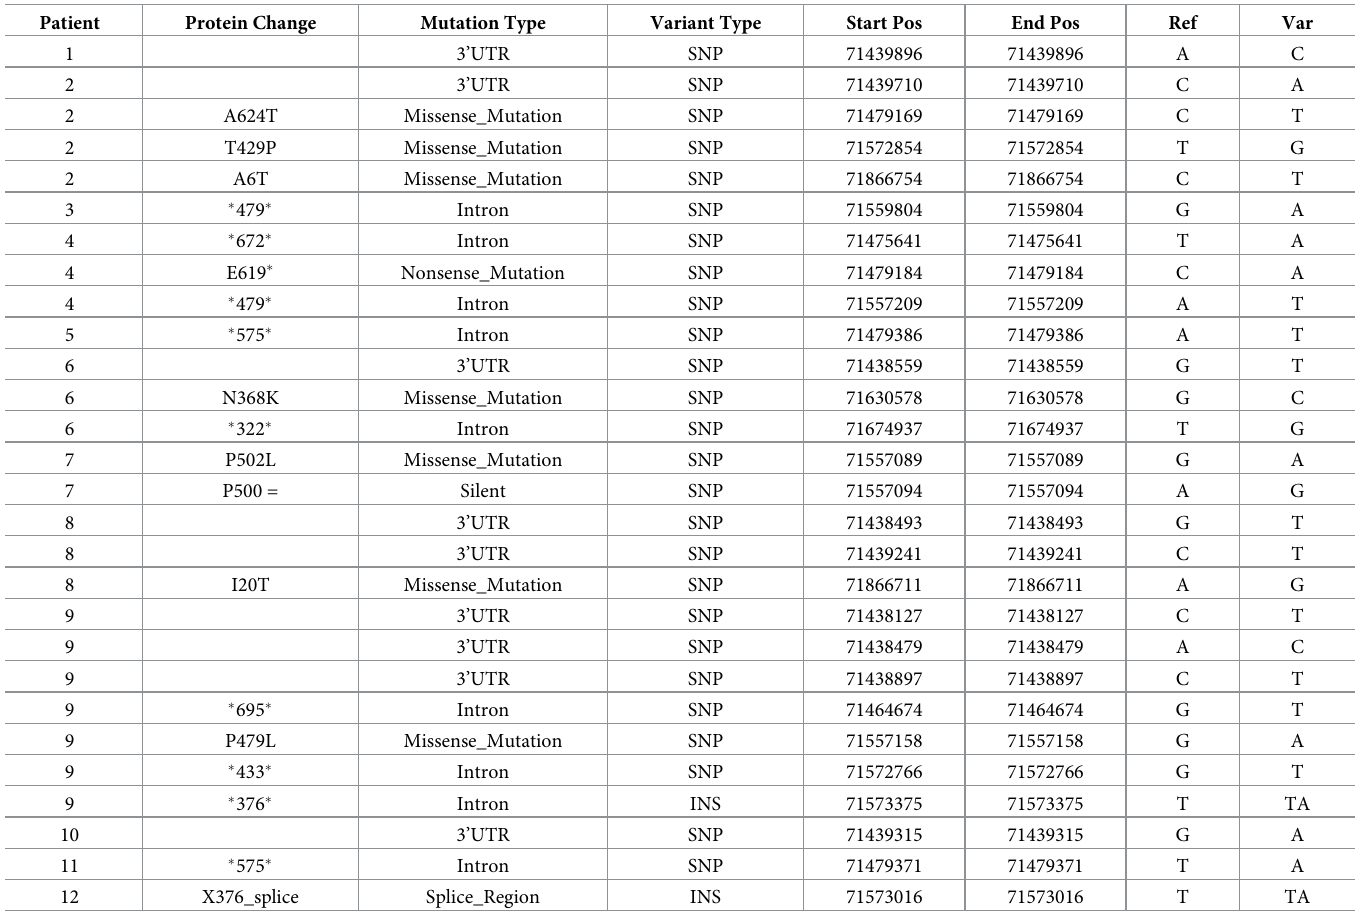
Table 2. Description of DACH1 gene mutations in the 12 DACH1 mutated patients at Markey Cancer